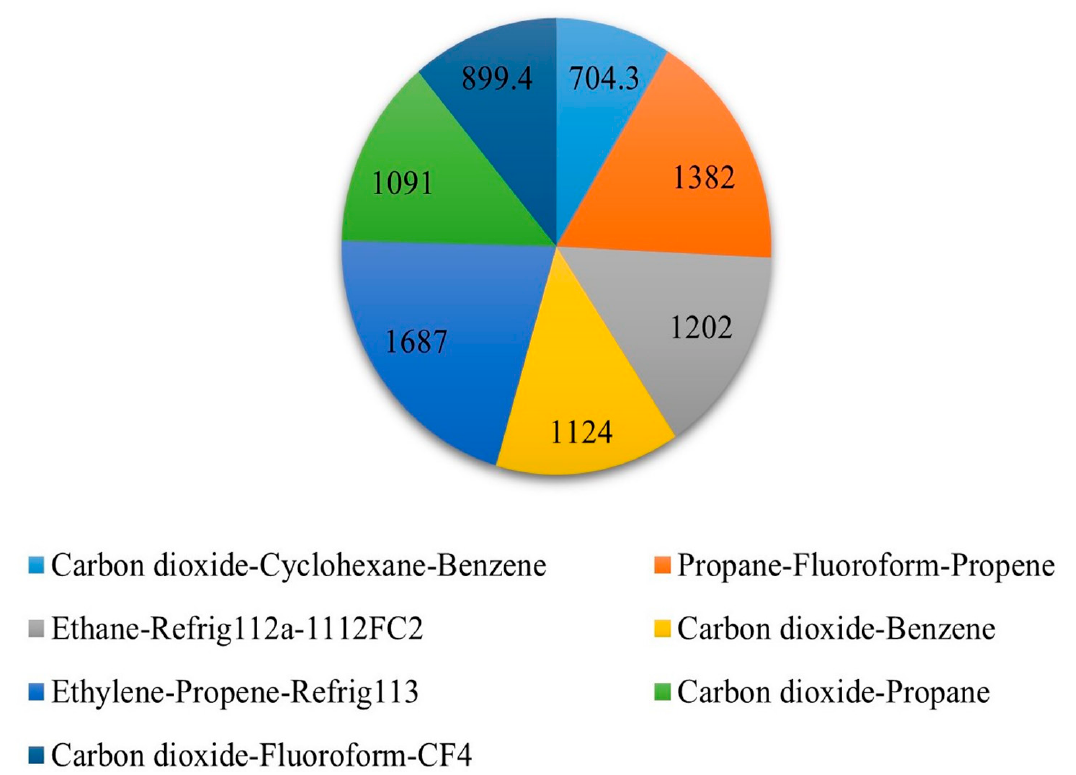
Figure 5. Demonstration of the total electricity generated by an ORC placing the working fluid in multiple modes.